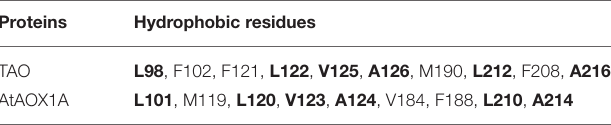
TABLE 1 | Residues lining the cavity of TAO and AtAOX1A. Proteins Hydrophobic